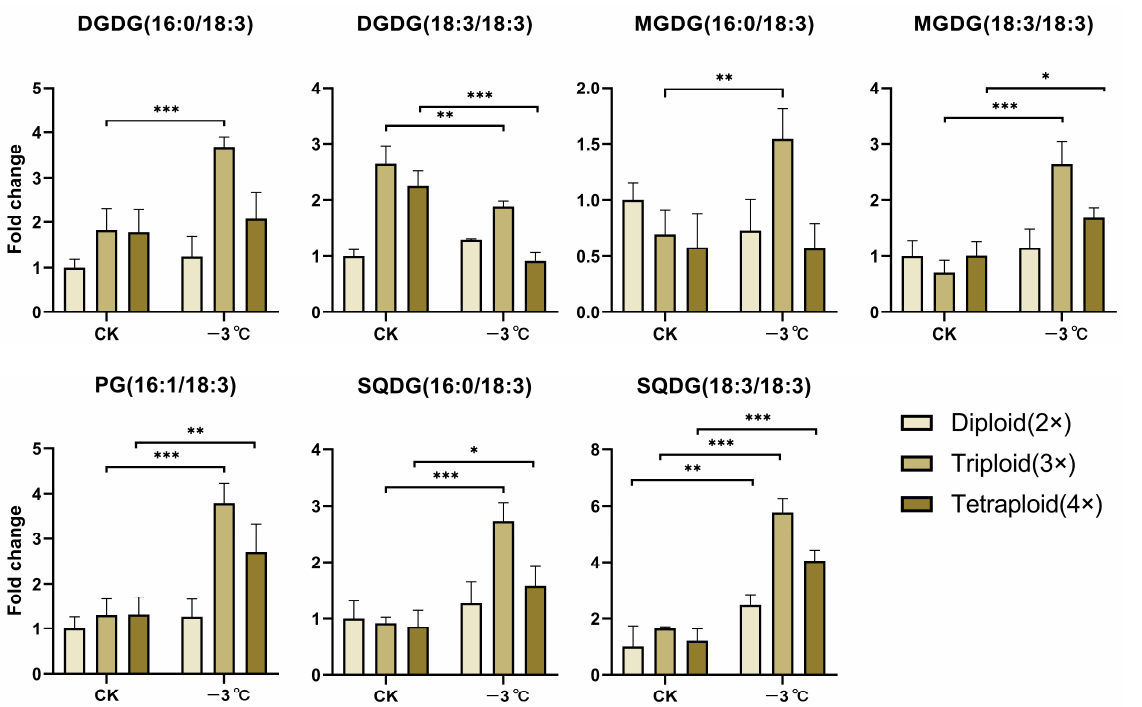
Figure 2. Changes in the quantity of membrane lipids associated with EjFAD8 in different ploidy loquats under low-temperature stress. Error bars, ±SD. Each analysis was repeated with three biological replicates. Asterisks denote signi fi cant di ff erences: * p < 0.05; ** p < 0.01; *** p < 0.001.